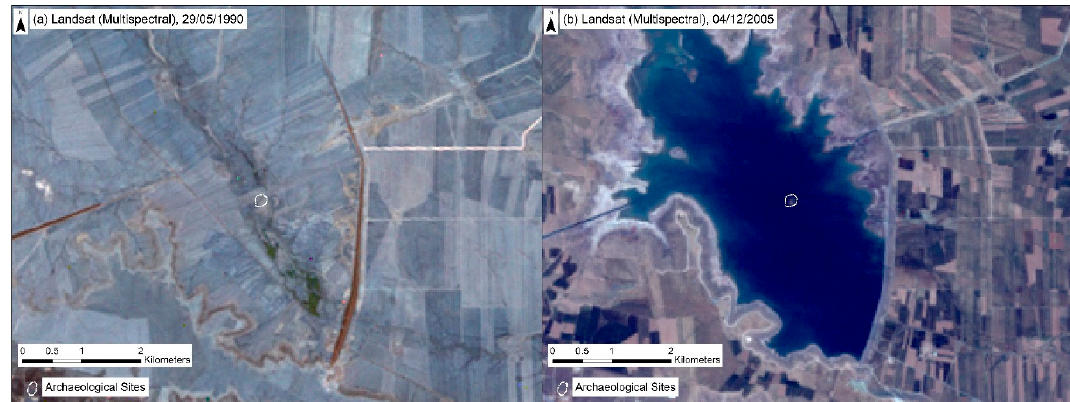
Figure 4. Al-Hasakah, Syria. ( a ) The site of Tell Abu Hufur in 1990; ( b ) The site has since been inundated by the West Hasakah dam. However, due to droughts in the area in 2013, the waters receded and the site was again exposed, causing erosion to the deposits.